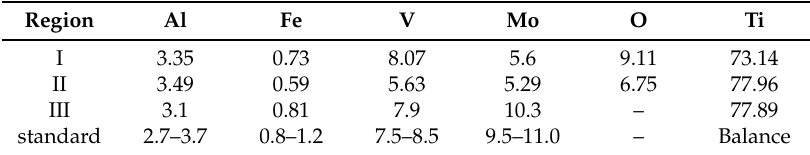
Table 2. Chemical constituents of the#4 screw (wt